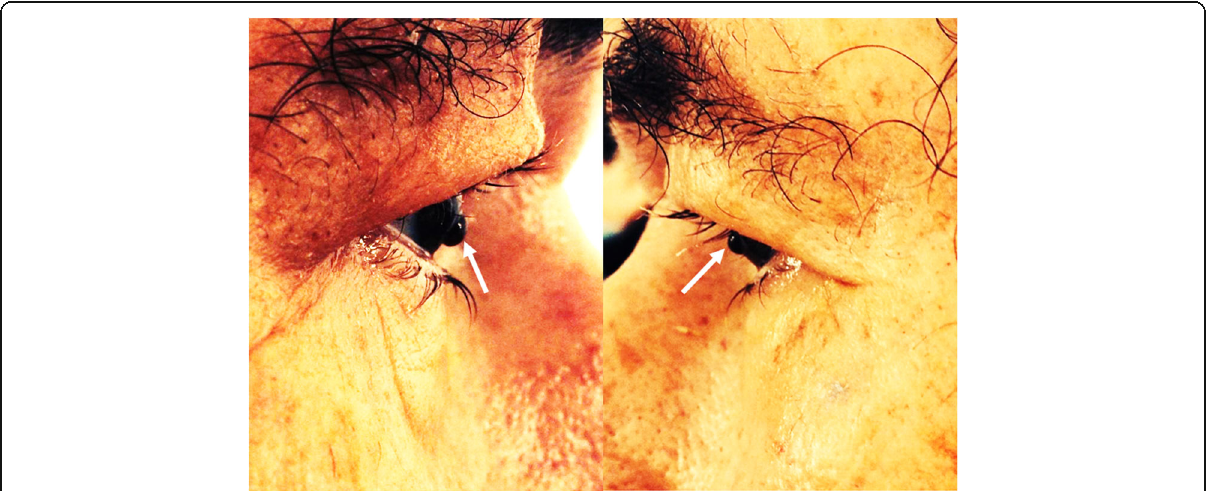
Fig. 2 Ocular involvement in GPA. Iridian herniation through the perforation of the corneas (white